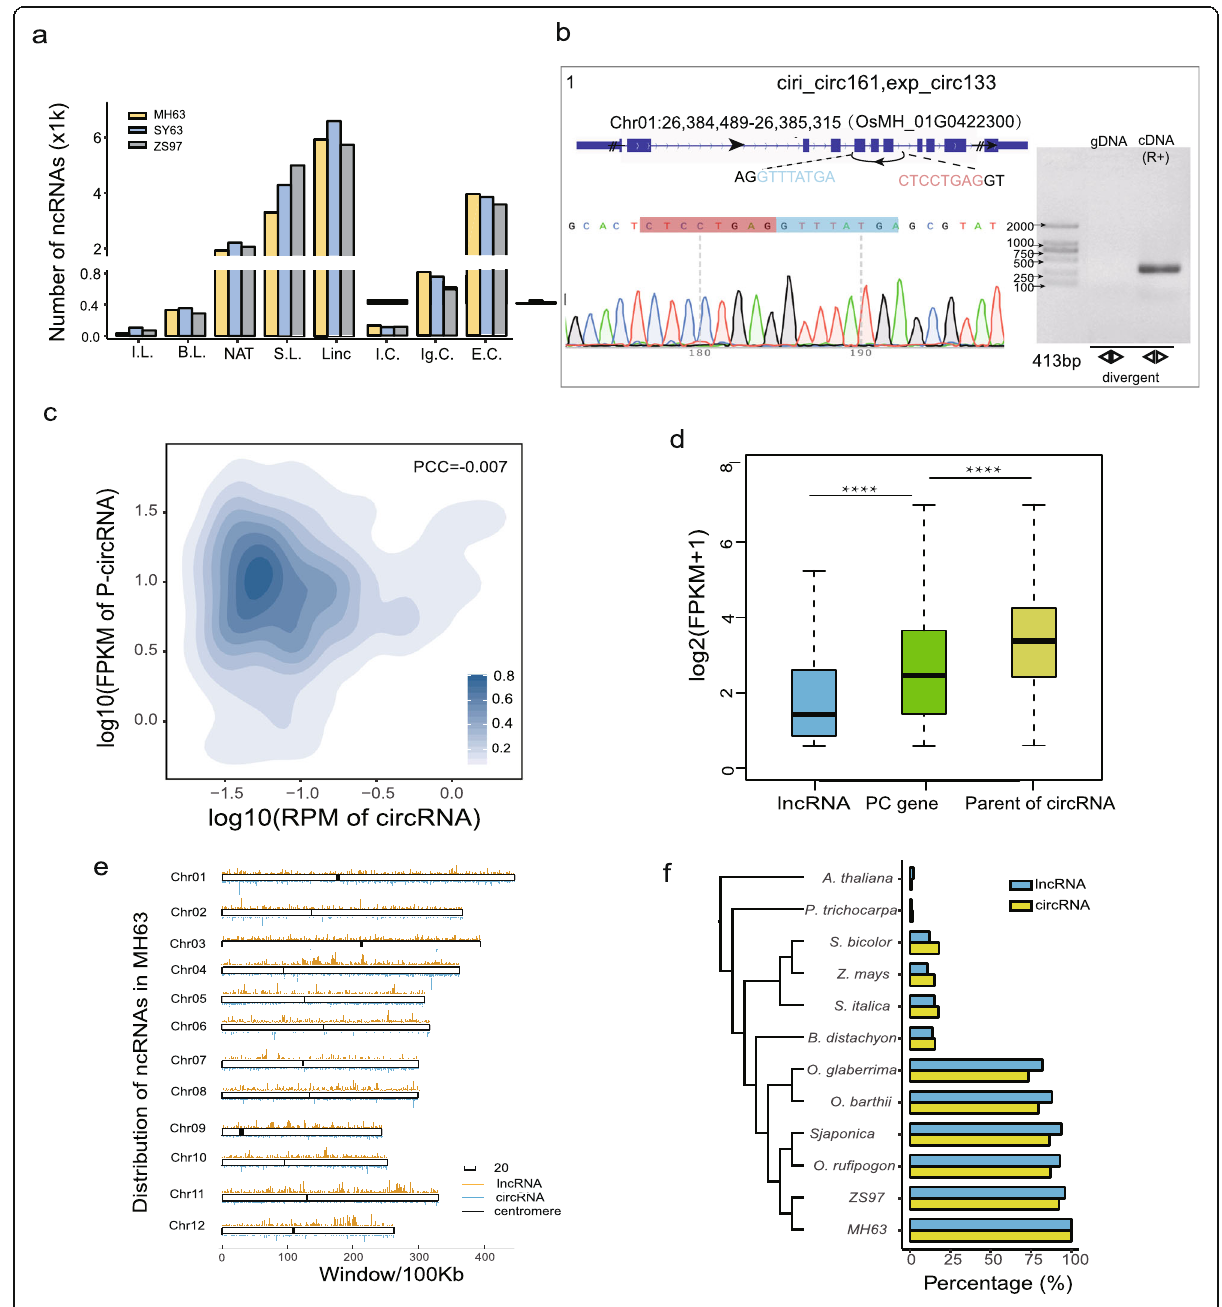
Fig. 1 Characteristics and comparative analysis of lncRNAs, circRNAs and mRNAs in rice. a Classification of the lncRNAs and circRNAs in MH63, SY63 and ZS97. From left to right: Intronic lncRNAs, Bidirectional lncRNAs, lncNAT, Sense lncRNAs, lincRNA, Intronic circRNA, Intergenic circRNA and Exonic circRNA. b An example of CircRNA that was successfully amplified and sequenced for the validation. R+ represents sample with RNase R treatment. The black dotted line represents the splice site. c The relationship between the expression of circRNAs (RPM) and their parental genes (FPKM) in panicle of MH63. d Comparison of expression (FPKM) between lncRNA loci, PC genes and circRNA parental genes in MH63 (**** indicates p -value< 0.0001). e Distribution of the number of lncRNAs and circRNAs in the chromosomes of MH63. f The phylogenetic tree